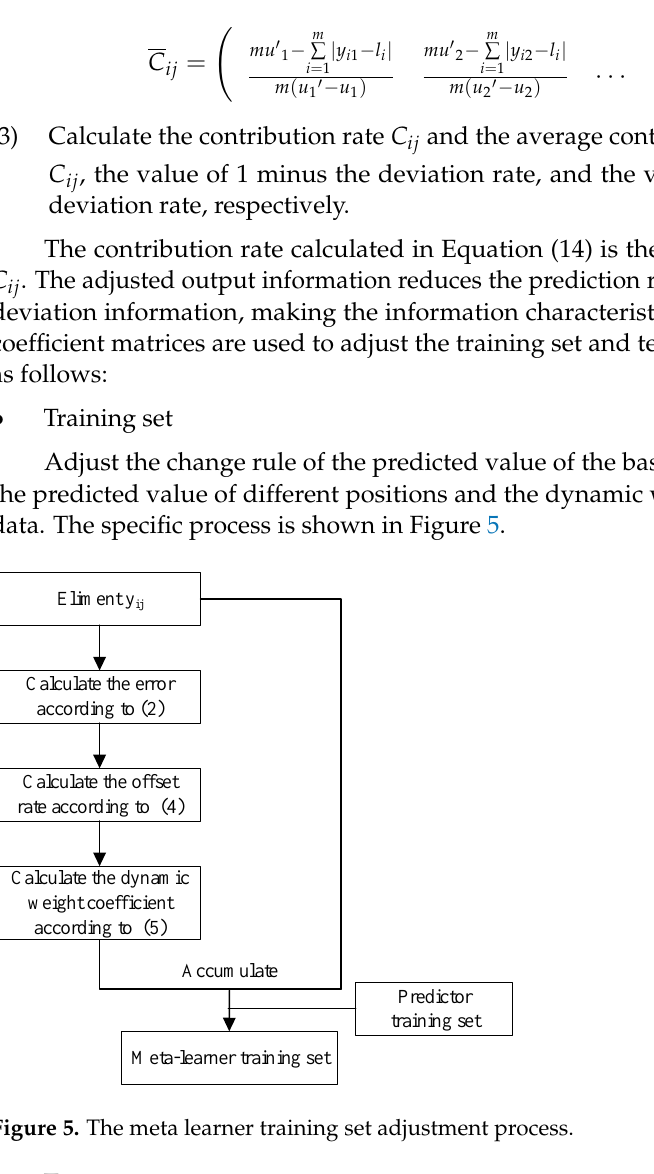
Figure 6. The meta learner test set adjustment process.